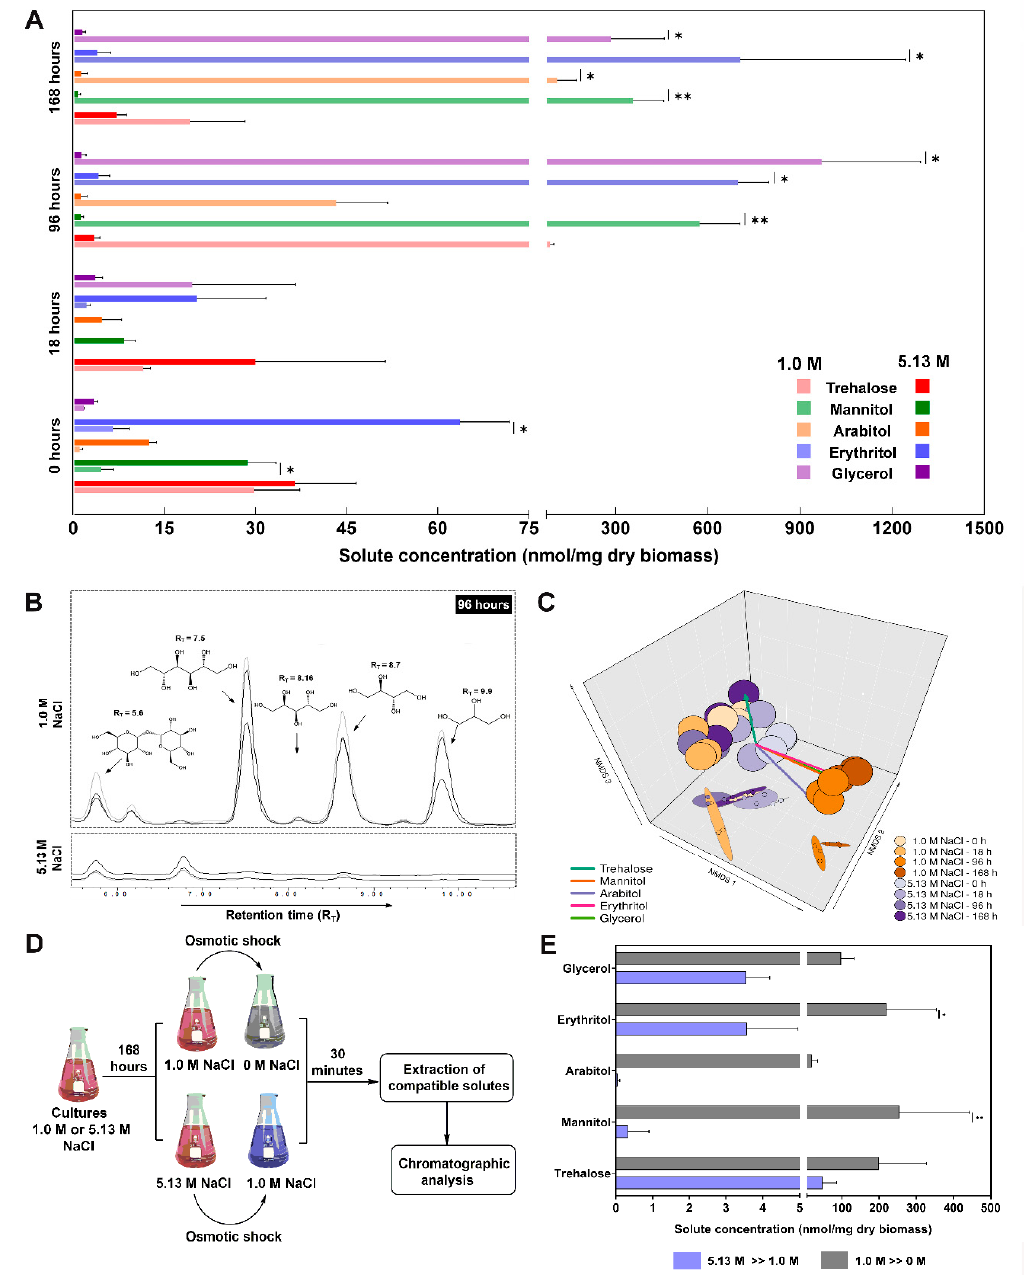
Figure 3. Osmolyte production by Aspergillus sydowii EXF-12860 grown at 1.0 M and 5.13 M NaCl (saturated NaCl solution) in Yeast Malt Broth at 28 °C. ( A ) Synthesis of compatibles solutes at 0, 18, 96 and 168 h. ( B ) Representative chromatograms obtained after 96 h of fungal culture at 1.0 M and 5.13 M NaCl. ( C ) Non-metrical multidimensional scaling (NMDS) analysis of the compatible solute production. ( D ) Experimental design to study the compatible solute production due to hypo-osmotic shocks. ( E ) Blue bars represent the compatible solute production after the hypo-osmotic shock from 5.13 M to 1.0 M NaCl. Grey bars represent the compatible solute production after the hypo-osmotic shock from 1.0 M to 0 M NaCl. Asterisks represent statistically significant differences determined by the Kruskal-Wallis test and Dunn’s test ( p ≤ 0.05), *( p ≤ 0.05) and **( p ≤ 0.01).